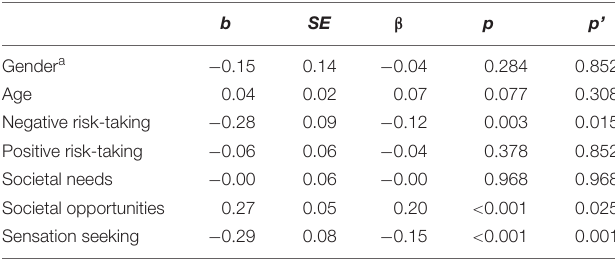
TABLE 4 | Coefficients for stepwise regression analysis with age, gender (step 1), negative/positive risk-taking (step 2), societal needs/opportunities (step 3) and sensation seeking (step 4) as predictors of life satisfaction. b SE β